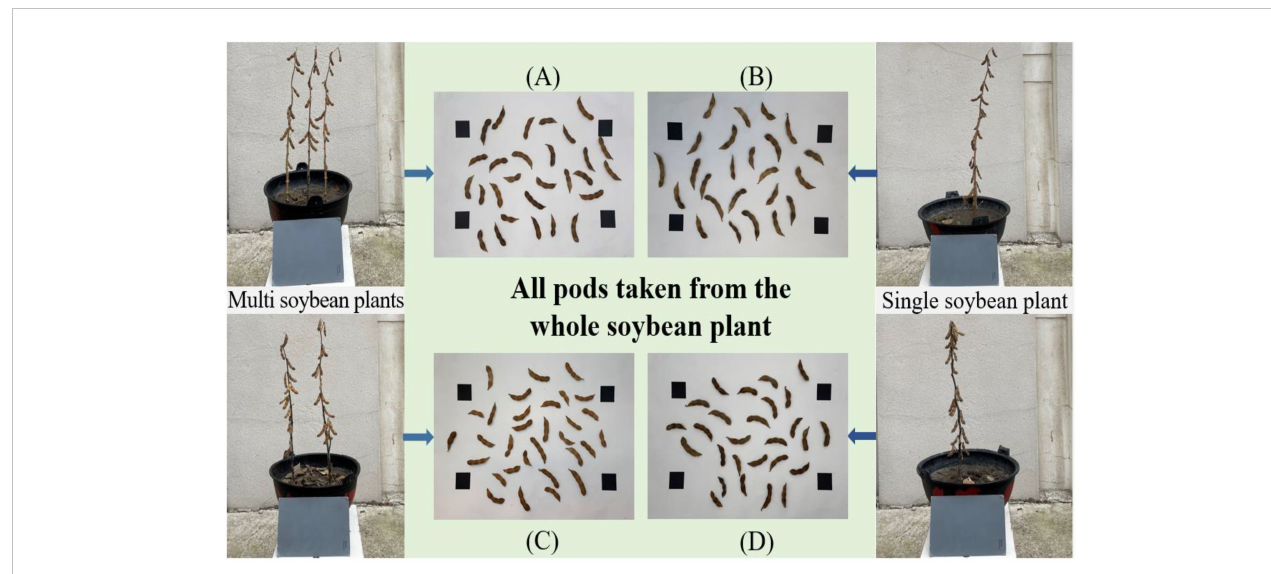
FIGURE 7 All mature soybean pods picked (A) , (C) Pods on multiple soybean plants; (B) , (D) Pods on single soybean